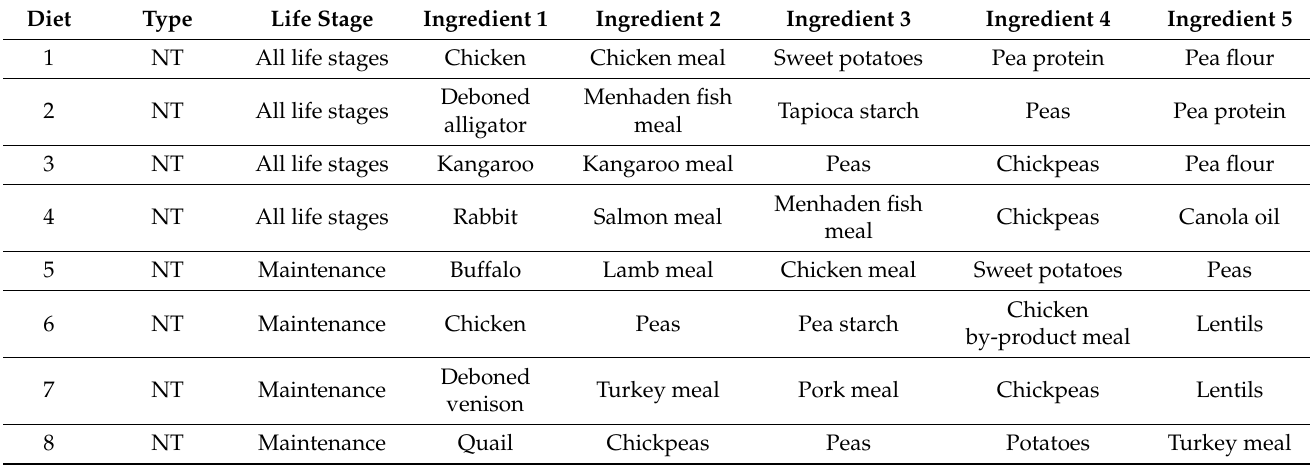
Table 1. Primary ingredients (listed in descending order of weight) in canine diets for maintenance and all life